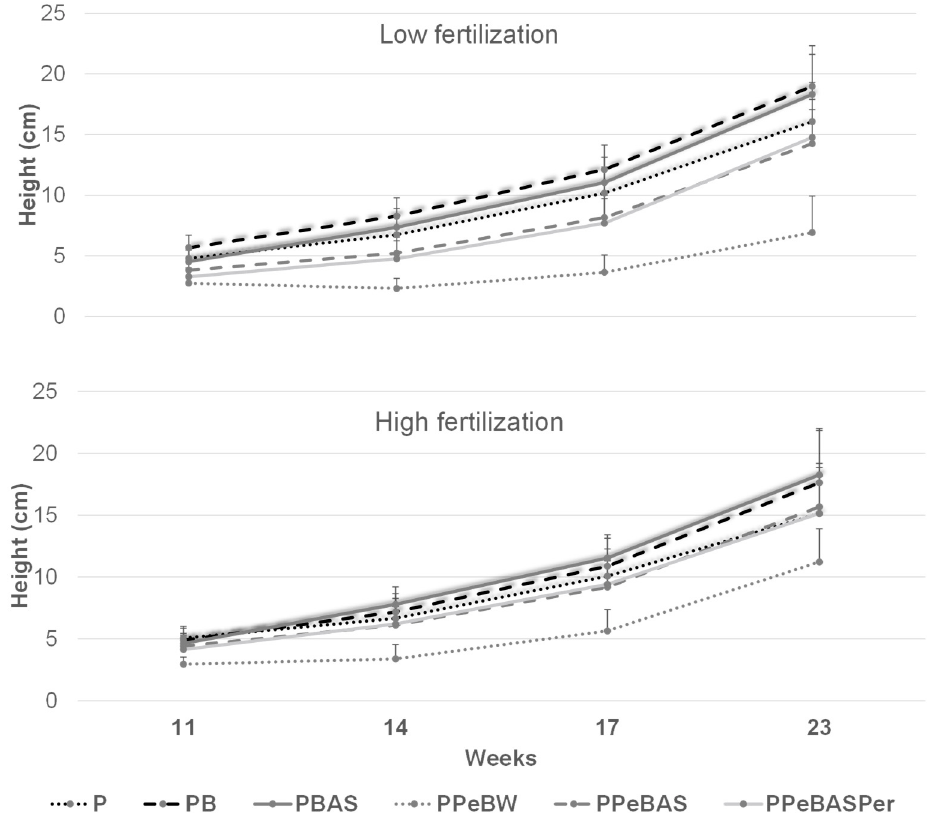
Figure 4. Height of spruce seedlings growing on the different substrates for 23 weeks: 100% peat (P), 75% peat plus 25% bulk biochar (PB), 75% peat plus 25% bulk biochar impregnated with ammonium sulfate (PBAS), 75% peat plus 25% biochar pellets with water (PPeBW), 75% peat plus 25% biochar pellets with ammonium sulfate (PPeBAS) and 62.5% peat plus 25% biochar pellets with ammonium sulfate plus 12.5% perlite (PPeBASPer), at low (half) and high doses (full) of fertilizer. The positive effect of bulk biochar on spruce growth, whether impregnated with ammonium sulphate or not, is more than evident for dry biomass (Figure 5). This was seen for both fertilizer treatments. Substrates with incorporated ammonium sulfate pellets (PPeBAS) had the same performance as the control (full dose of fertilizer). In contrast, substrates with water pellets resulted in significantly lower biomass. This suggests that the pellets may slightly limit growth by holding more water and reducing gas exchanges. This is because of an interaction with the nitrogen from water pellets where growth is limited. On the other hand, when ammonium sulfate is added to the pellets with a full dose of fertilizer, the amount of dry biomass is equivalent to the control substrate (only peat).